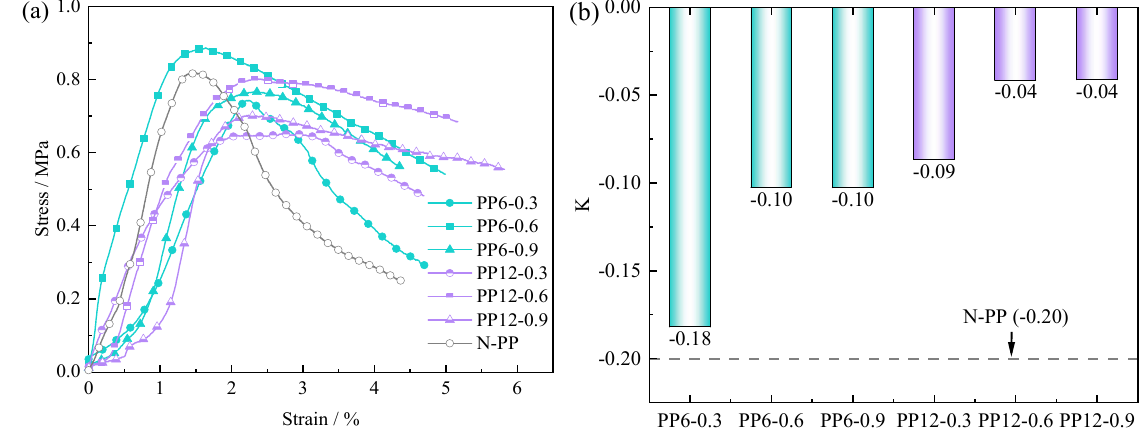
Figure 4. Stress–strain curves and slopes of post-peak curves for FRCTWRF specimens: ( a ) stress– strain plots; ( b ) slopes of post-peak curves.